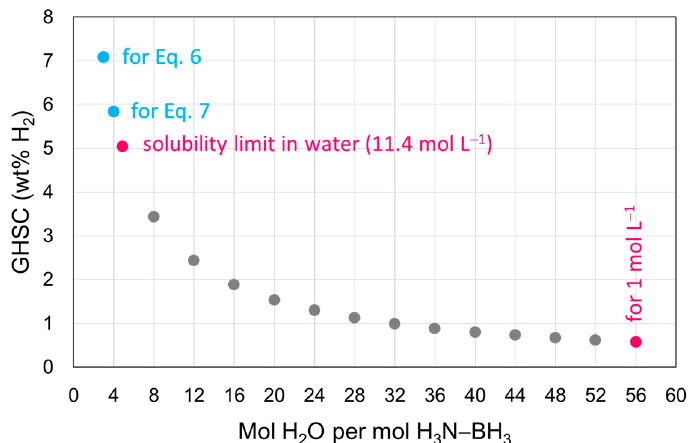
Figure 5. Evolution of the gravimetric hydrogen storage capacity (GHSC) of the couple ammonia borane–water as a function of the mole number of water per mole of ammonia borane. The capacities (7.1 and 5.8 wt% H 2 ) in stoichiometric conditions (Equations (6) and (7)) are shown. The capacities calculated for an ammonia borane concentration of 11.4 mol L − 1 (solubility limit of ammonia borane in water) and a concentration of 1 mol L − 1 are also shown (5 and 0.6 wt% H 2 respectively).